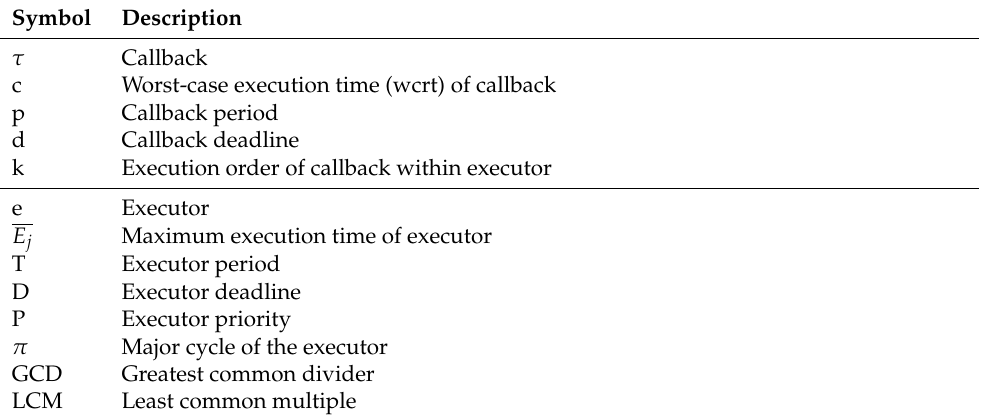
Table 2. Main notations used in this